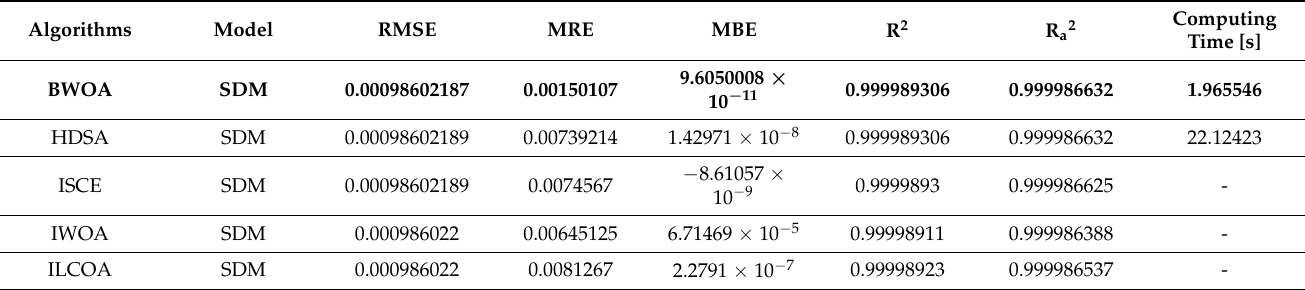
Table 3. Statistical tests of the RTC photovoltaic cell for different